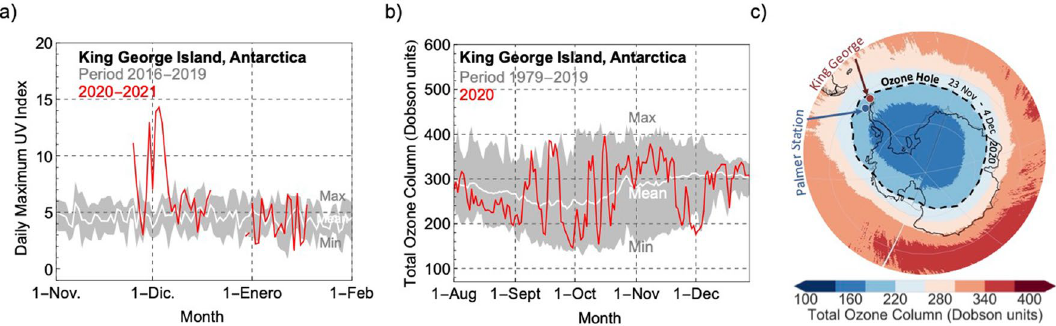
Figure 1. Large ozone losses in late spring 2020 led to extremes of surface ultraviolet radiation at the northern tip of the Antarctic Peninsula. ( a ) Progress of the daily maximum UV index measured on King George Island in late 2020 and early 2021 (red line). The gray shading indicates the highest and lowest values measured over the period 2016–2019 while the white line indicates the mean over the same period. ( b ) Progress of the total ozone column (TOC) for 2020 (red line). The gray shading indicates the highest and lowest values measured over the period 1979–2019 while the white line indicates the mean over the same period. Note that although 2020 was the lowest value for early December, the ozone has shown similarly low values in late spring in the past. Multi-satellite data (TOMS instruments onboard the Nimbus-7 satellite, on the Meteor-3 satellite, and on the Earth Probe satellite, as well as the OMI instrument onboard the Aura satellite) were used for this plot. ( c ) Mean of the total ozone column over Antarctica from 24 November 2020 to 4 December 2020. The dashed line indicates the 220 Dobson units (DU) threshold that defines the ozone hole. The locations of King George Island (62°12 ′ S, 58°58 ′ W) and Palmer Station (64°46 ′ S, 64°03 ′ W) are shown in the plot. Note that the ozone hole